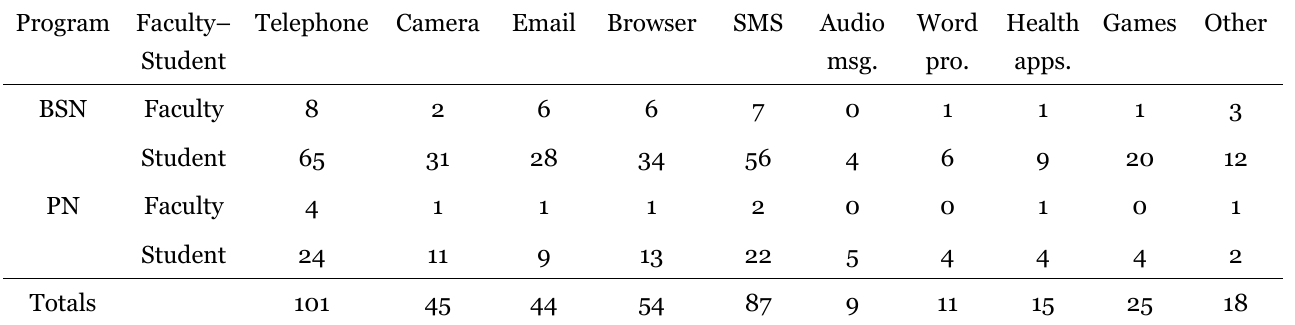
Mobile Device Features Used at Least Once a Week